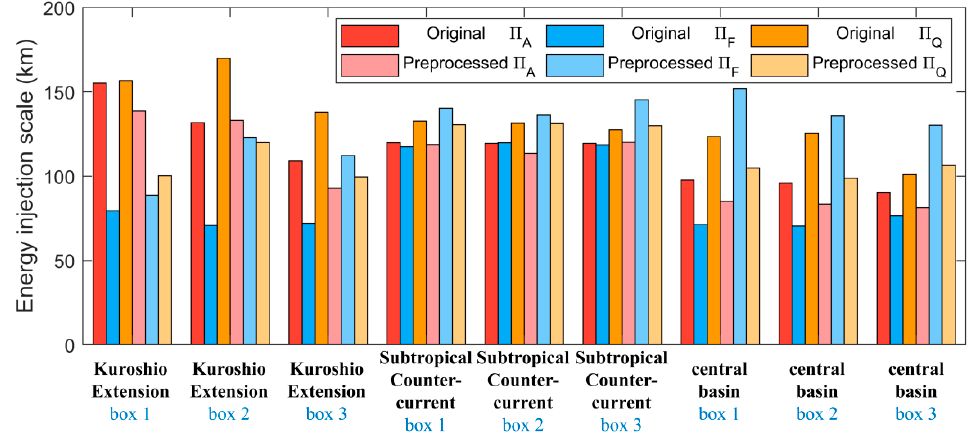
Figure 6. Energy injection scale L inj from Π A , Π F , and Π Q in the nine subregions shown in Figure